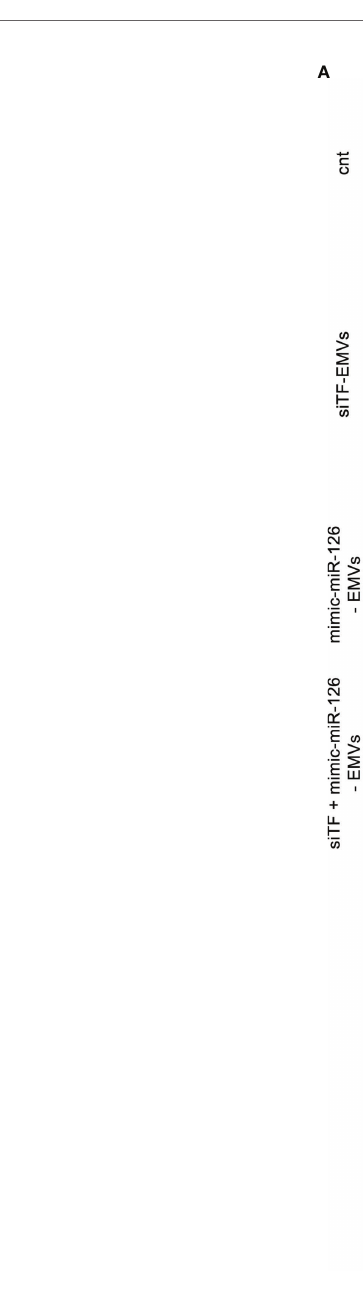
FIGURE 3 | TF is needed for transferring MiR-126 from EMVs to monocytic cells. (A) Immuno fl uorescence staining of 24-h cultures of RMCs (stained with PKH67 Green Fluorescence Cell Linker) and EMVs (stained with PKH67 Red Fluorescence Cell Linker) isolated from ECs transfected with empty vector (cnt), TF silenced (siTF), mimic miR-126 (miR-126 mimic), and TF silenced and mimic miR-126 (siTF + miR-126 mimic). Colocalization is shown in white. Cyto fl uorograms are shown together with confocal images. (B) qRT-PCR was used to assess the expression of miR-126 in RMCs cultured for 24 h without ( − ) or with EMVs released from activated control ECs, TF-overexpressing ECs (upTF), or TF-silenced ECs (siTF). Values are expressed as mean ± SEM. Statistical analysis was performed by ANOVA followed by Tukey ’ s post-hoc test. ## p < 0.01 vs. RMCs without EMVs ( − ), ** p < 0.01 and *** p < 0.001 vs. RMCs with EMVs from ECs transfected with empty vector (cnt) ( N =